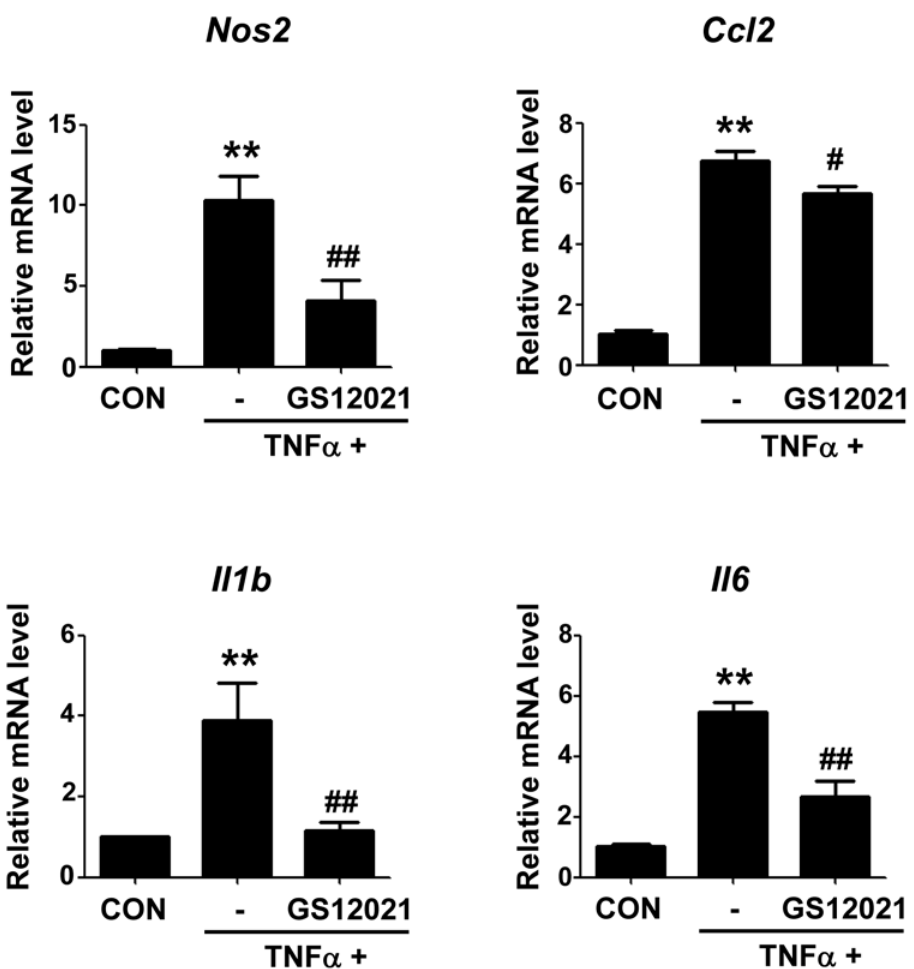
Fig 9. The effect of GS12021 treatment on the adipocyte inflammation. Fully differentiated 3T3-L1 adipocytes were treated with TNF α (10 ng/ml) for 6 h in the presence or absence of GS12021 (20 μ M). mRNA levels of iNOS, MCP-1/CCL2, IL-1 β and IL-6 were measured by RT-qPCR (N = 3). ** P < 0.01 versus CON; # P < 0.05, ## P < 0.01 versus TNF α